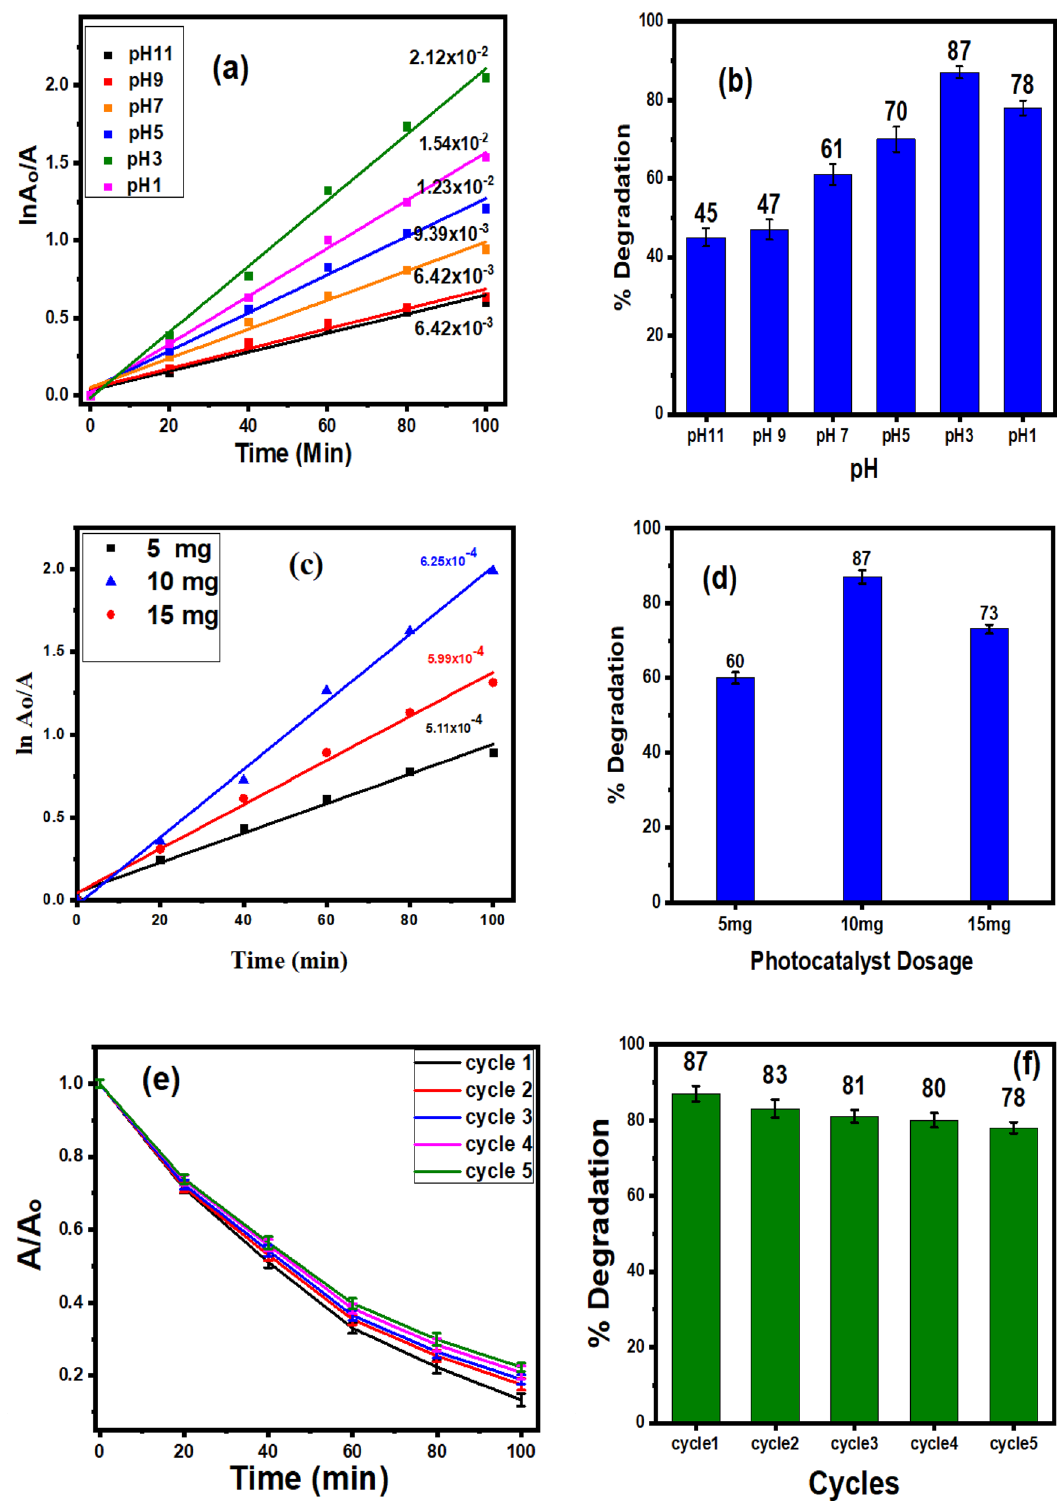
Figure 8. Photocatalytic degradation of MO ( a ) kinetic simulation, ( b ) bar graph % degradation at various pH, ( c ) Kinetic simulation, ( d ) Bar graph of % degradation at different catalyst dosage, ( e ) Reusability of Ag 0.04 ZrO 2 / rGO up to 5 cycles, ( f ) Bar graph of